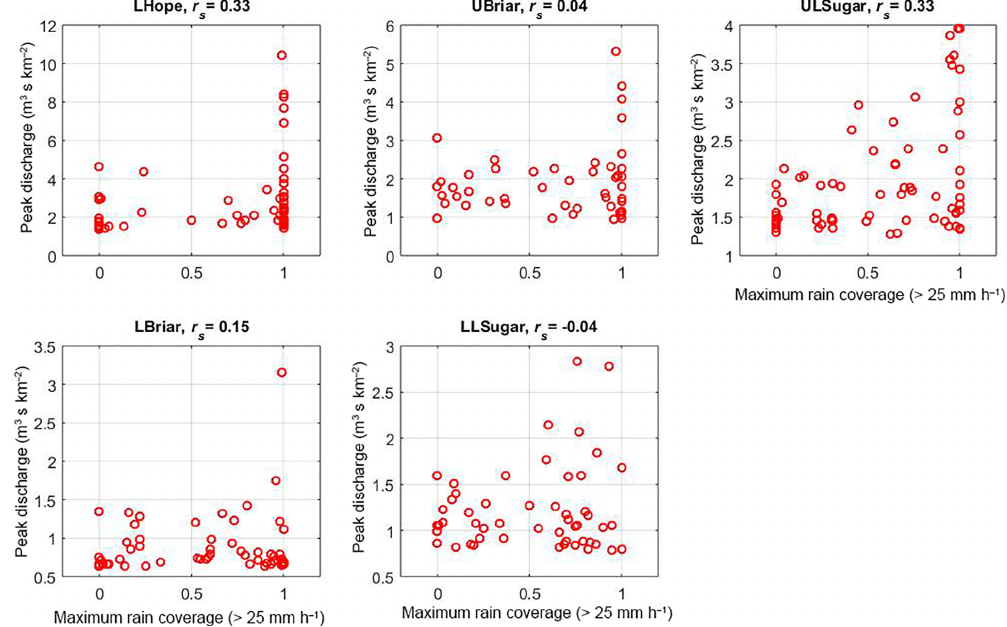
Figure 4. Scatter plots of basin fractional coverage by rainfall intensities >25mmh − 1 versus peak flow, per event, for the five basins in Little Sugar Creek catchment and associated values for Spearman rank correlation